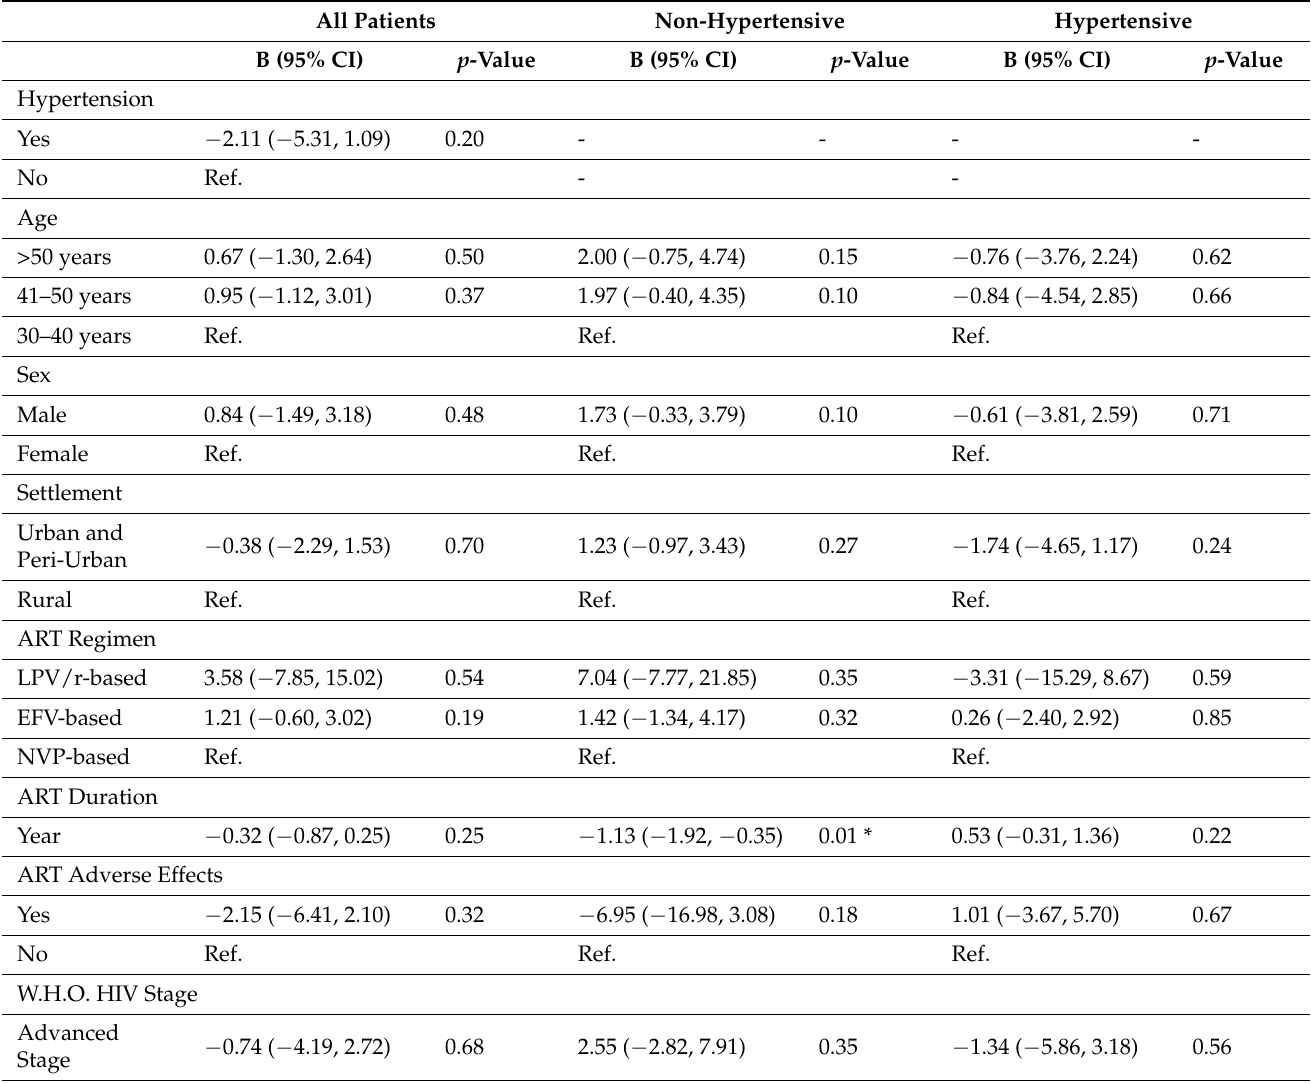
Table 5. Factors Associated with